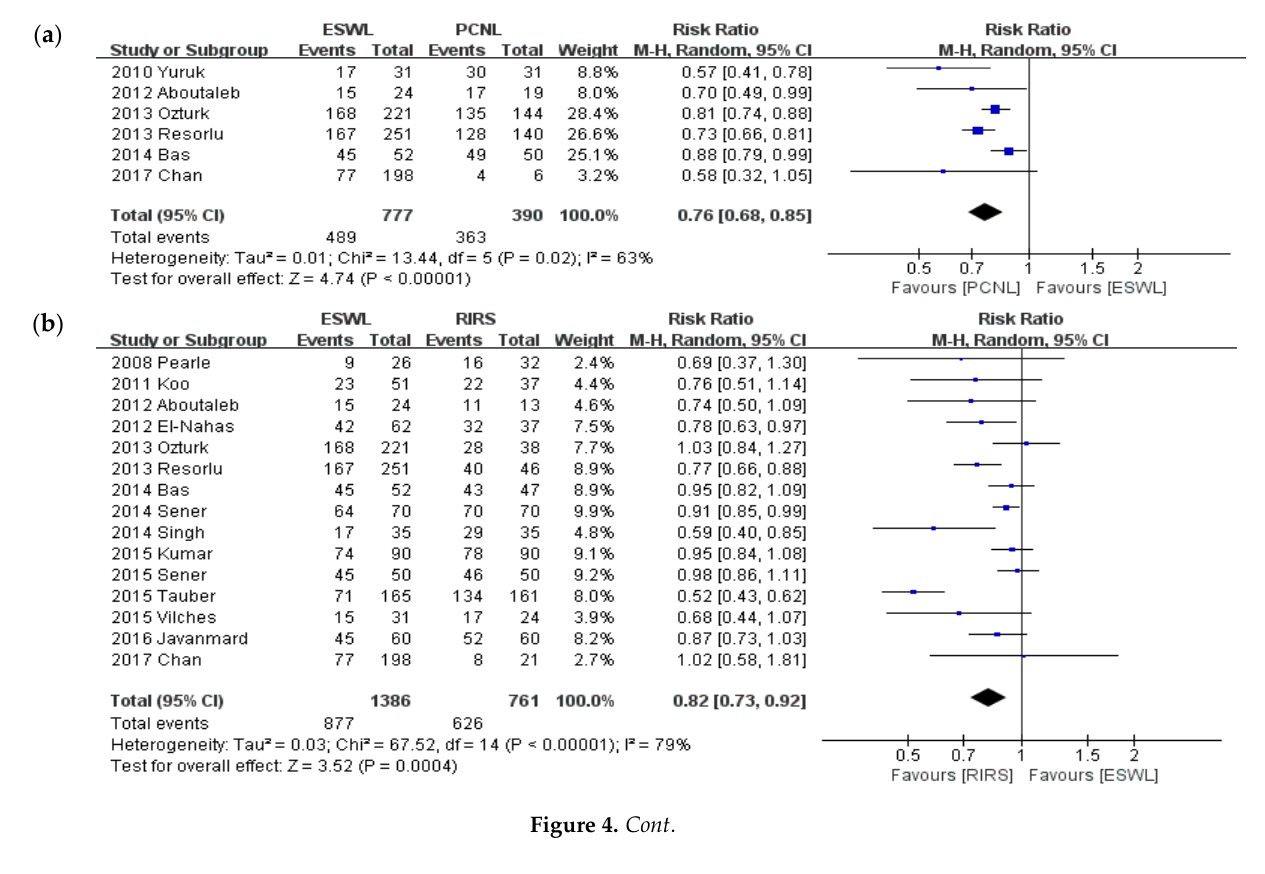
Figure 3. Meta-analysis of Stone-free rate: ( a ) ESWL versus PCNL; ( b ) ESWL versus RIRS; and ( c ) PCNL versus RIRS. Mantel-Haenszel (M-H), 95% confidence intervals (CI).